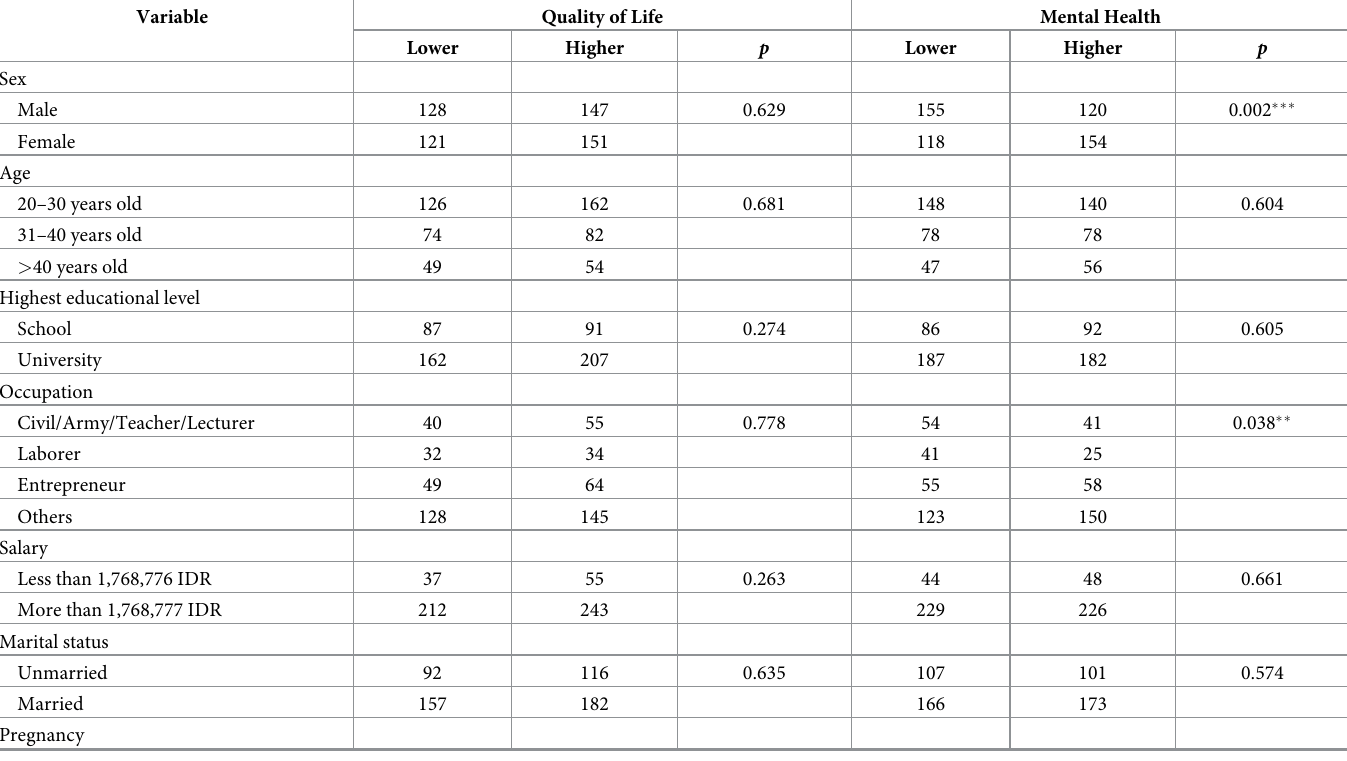
Table 2. Bivariate analysis of quality of life and mental health among COVID-19 survivors in Indonesia.